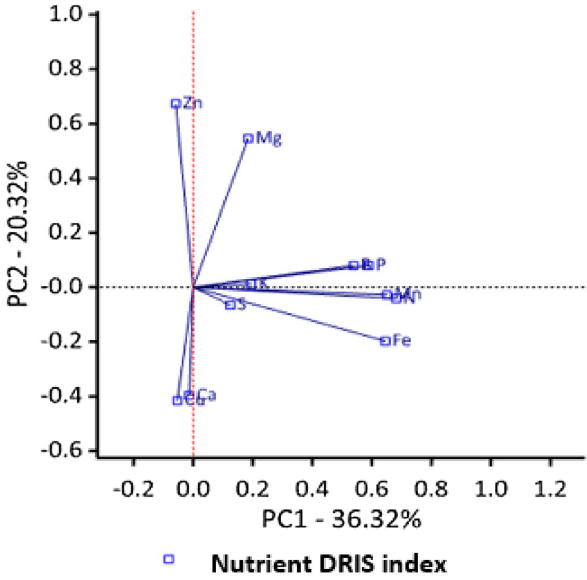
Figure 2. Relationship among nutrients DRIS indices and maize grain yield.